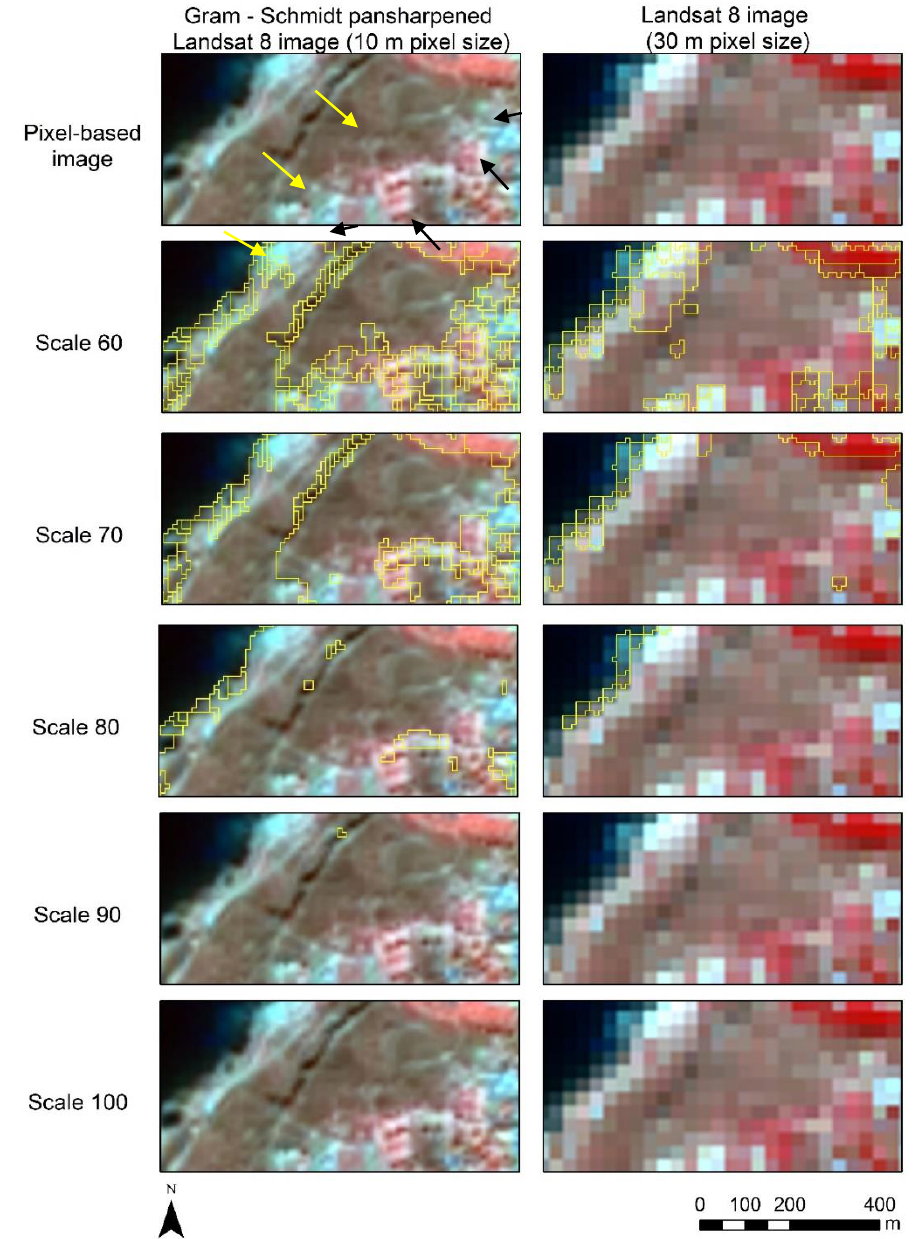
Figure 7. Segmentation results for area b of Figure 1 using a scale factor from 60 to 100, with a step of 10, applied at the Gram–Schmidt pansharpened Landsat 8 image (left) and the original Landsat 8 image (right). Groups of pixels (segments) are visualized in both images with a blue polygon. Similar results for scales 10 to 50 are shown in Figure 6. The standing defensive wall is indicated with yellow arrows and the archaeological proxies are indicated with black arrows.